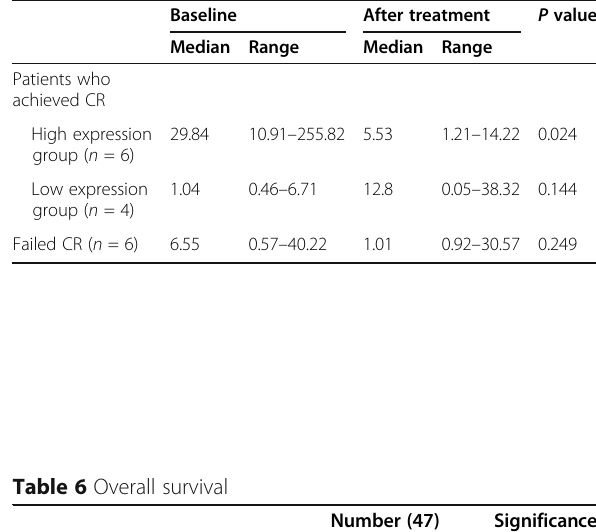
Table 6 Overall survival